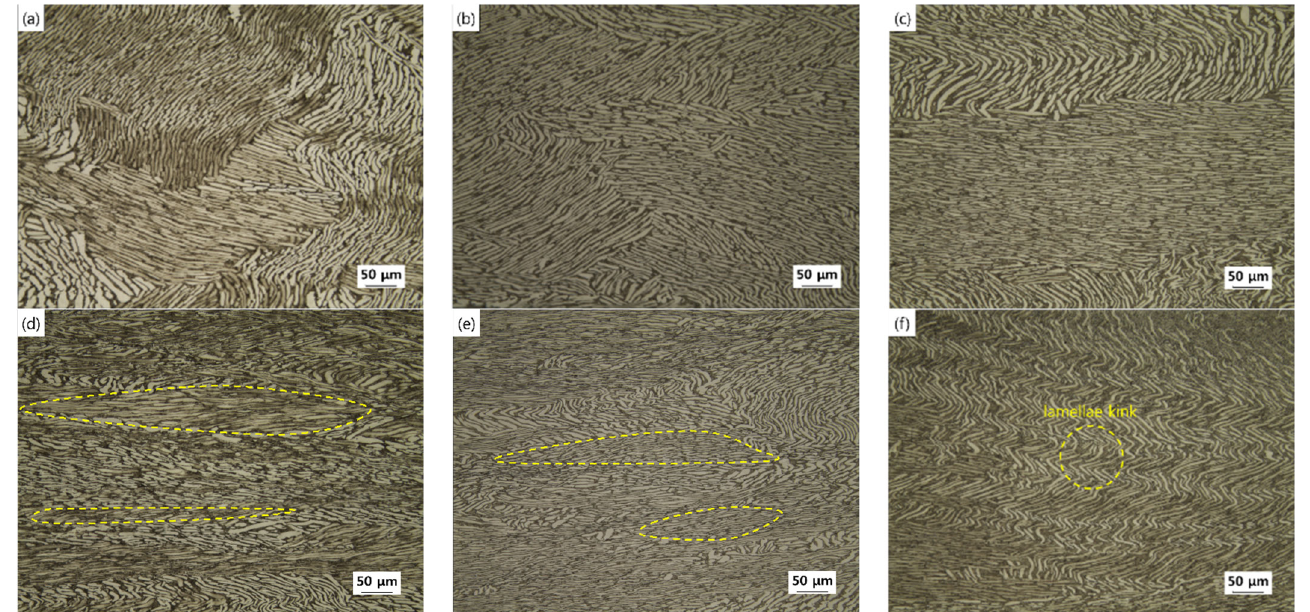
Figure 13. Microstructures of the cross-sectioned areas according to each condition after high- temperature compression of Ti-6Al-4V alloy; ( a , d ) 800 ◦ C, 1 × 10 − 2 /s, ( b , e ) 800 ◦ C, 1 × 10 0 /s, ( c , f ) 850 ◦ C, 1 × 10 − 2 /s; ( a – c ) Dead Zone, ( d – f ) Severe Plastic Deformation